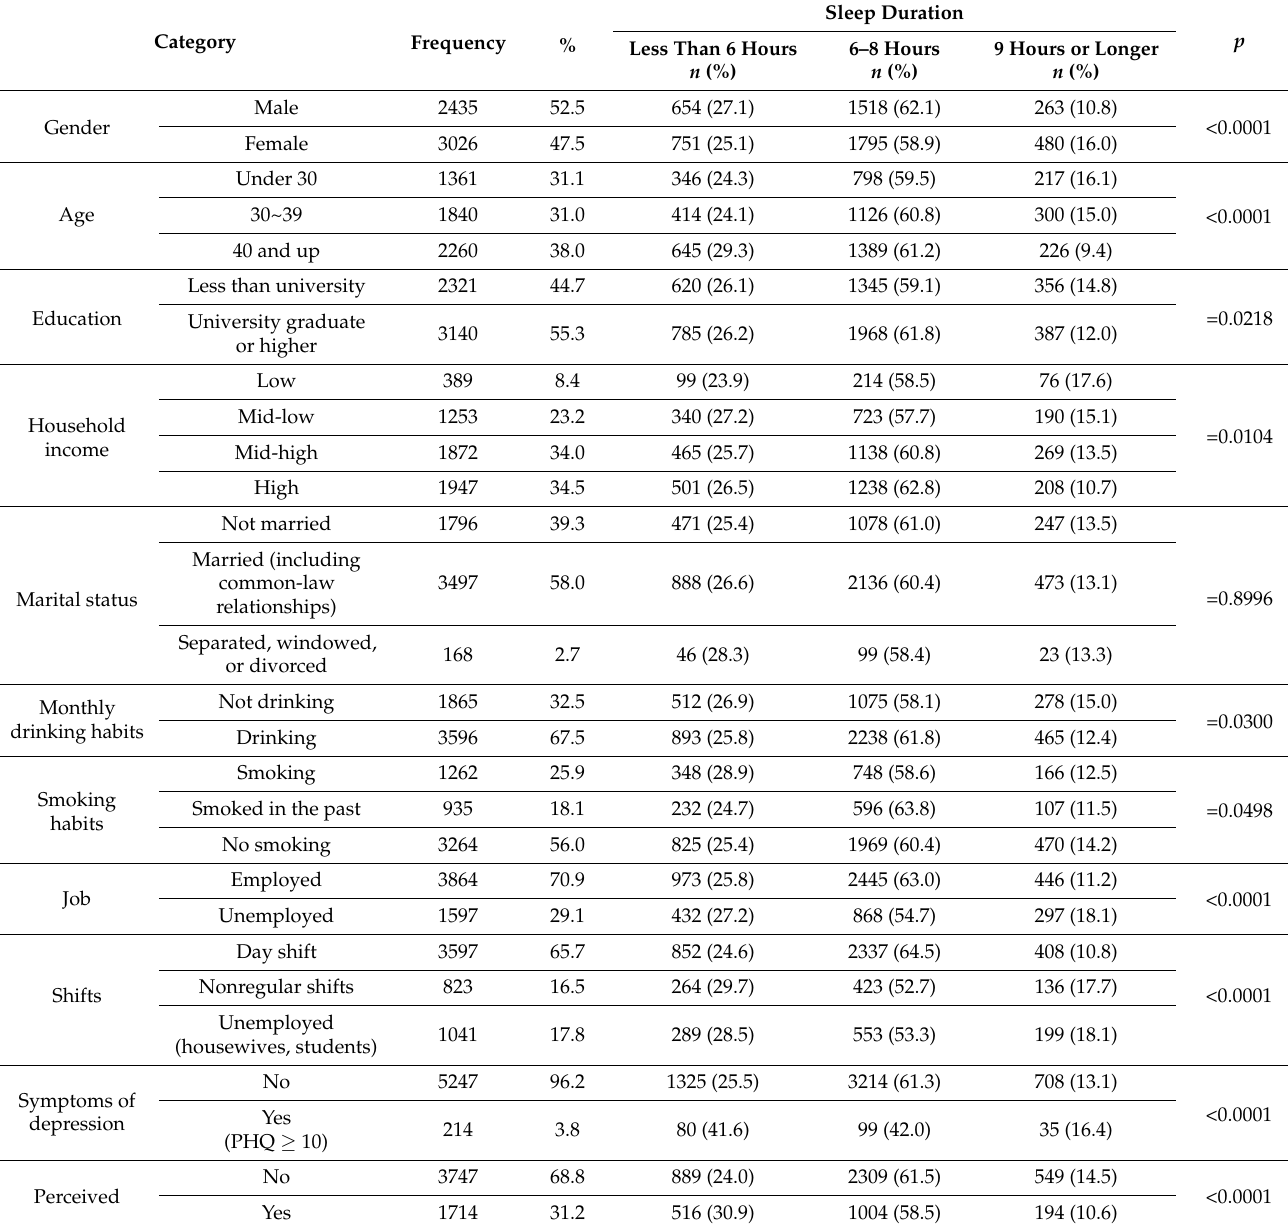
Table 1. Demographic